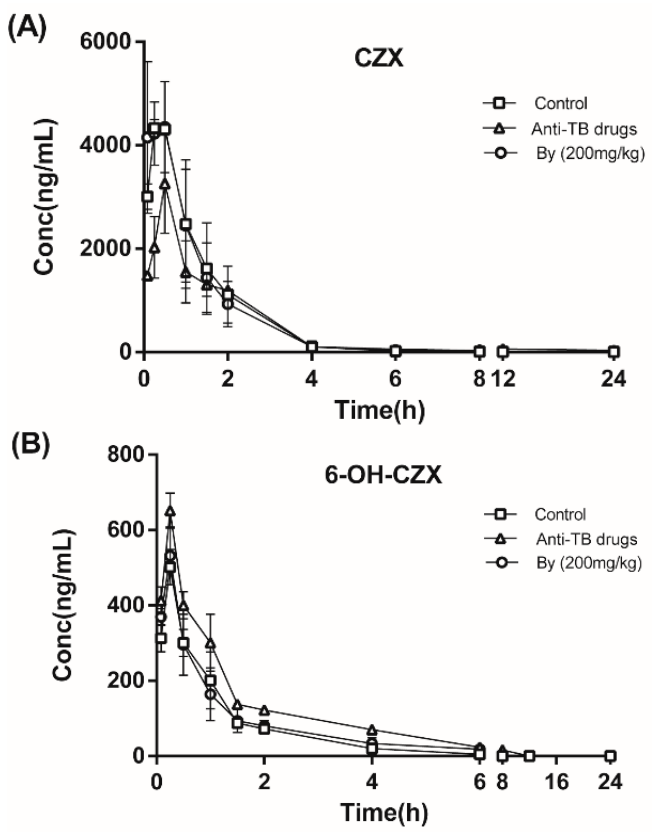
Figure 9. Mean plasma concentration-time curves of CZX ( A ) and 6-OH-CZX ( B ) in the control, anti-TB drug-intoxicated, and bicyclol (200 mg/kg)-treated rats after oral administration of CZX at 20 mg/kg.